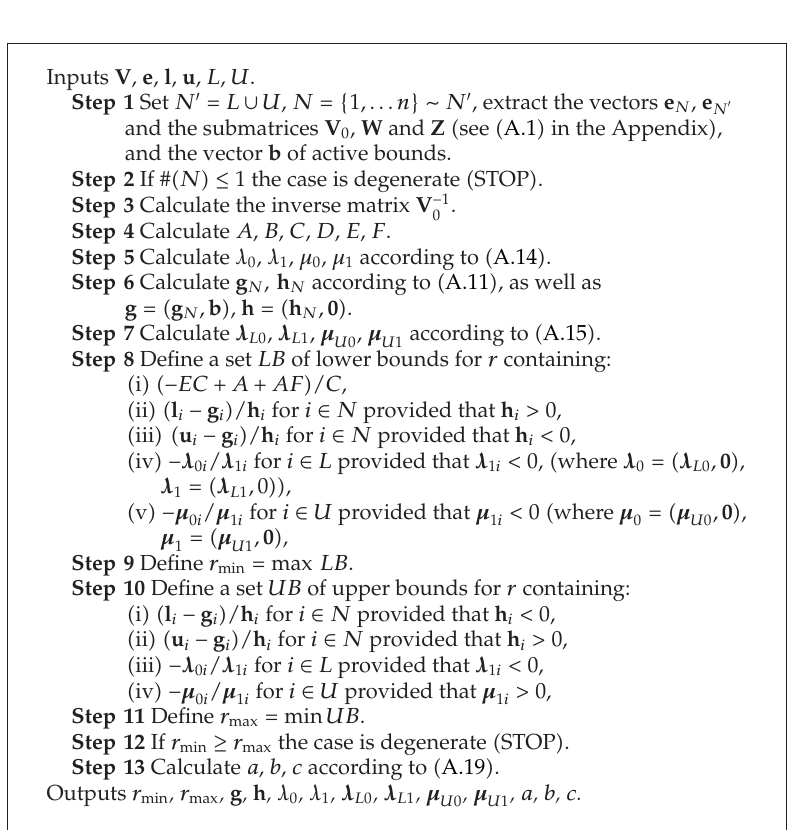
Algorithm 1: The KTEF